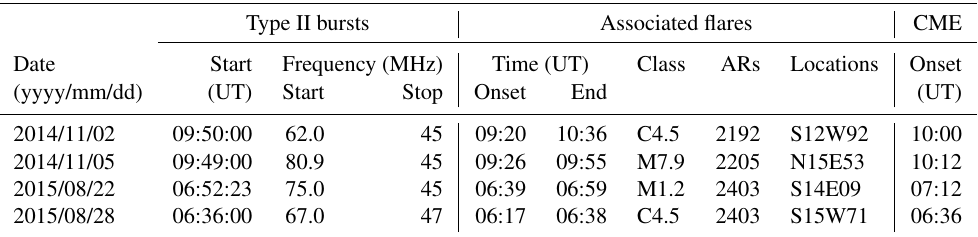
Figure 2. Panel (a) shows the observation coverage by the CALLISTO station at University of Rwanda in Kigali. Panel (b) displays the spectral overview Kigali,Rwanda. Strong peaks near 100, 500 and 800MHz are due to FM radio, digital video broadcast and mobile phone transmitters. Negative peaks with respect to the blue baseline are due to saturation of the spectrometer from strong local transmitters. The best frequencies for solar burst observations are 45–80, 150–450 and 600–800MHz due to low interference. Table 1. Type II SRBs observed by the e -CALLISTO network at the Kigali